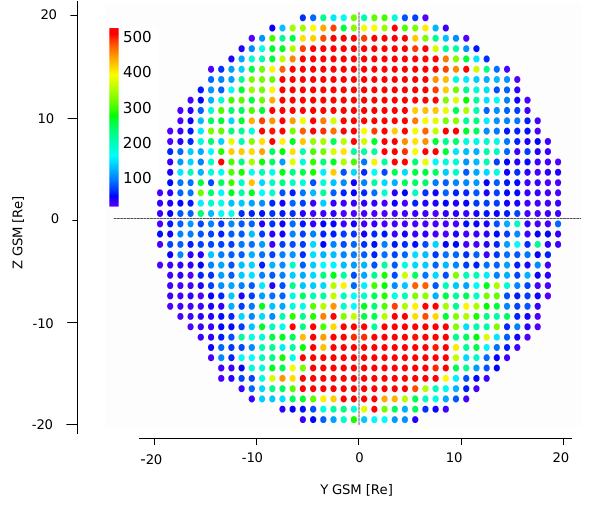
Fig. 3. Spatial coverage. Approximately 340000 data points (corresponding to more than 5700 hours of measurements) have been mapped into 1 x 1 R E bins at a plane 10 R E downtail. The colors of the symbols indicate the number of mapped EDI vectors in each bin. The view is from the Earth, looking tailward.